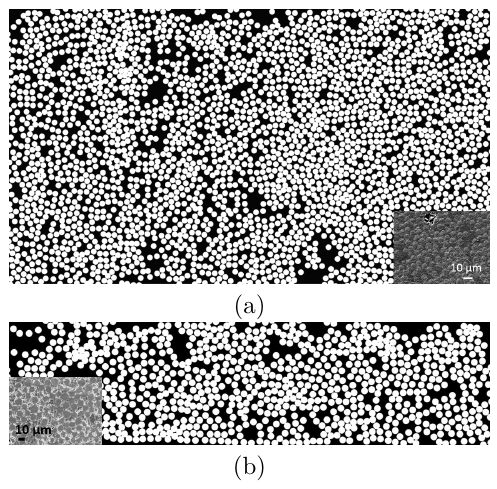
Figure 2. Cross-sections of examined fibrous com- posites. a) Carbon fiber composite, b) basalt fiber composite.